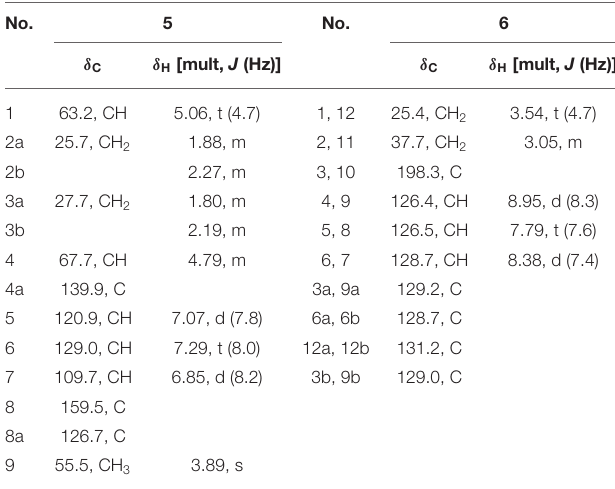
TABLE 3 | 1 H and 13 C NMR data of 5 and 6 in CDCl 3 . No.